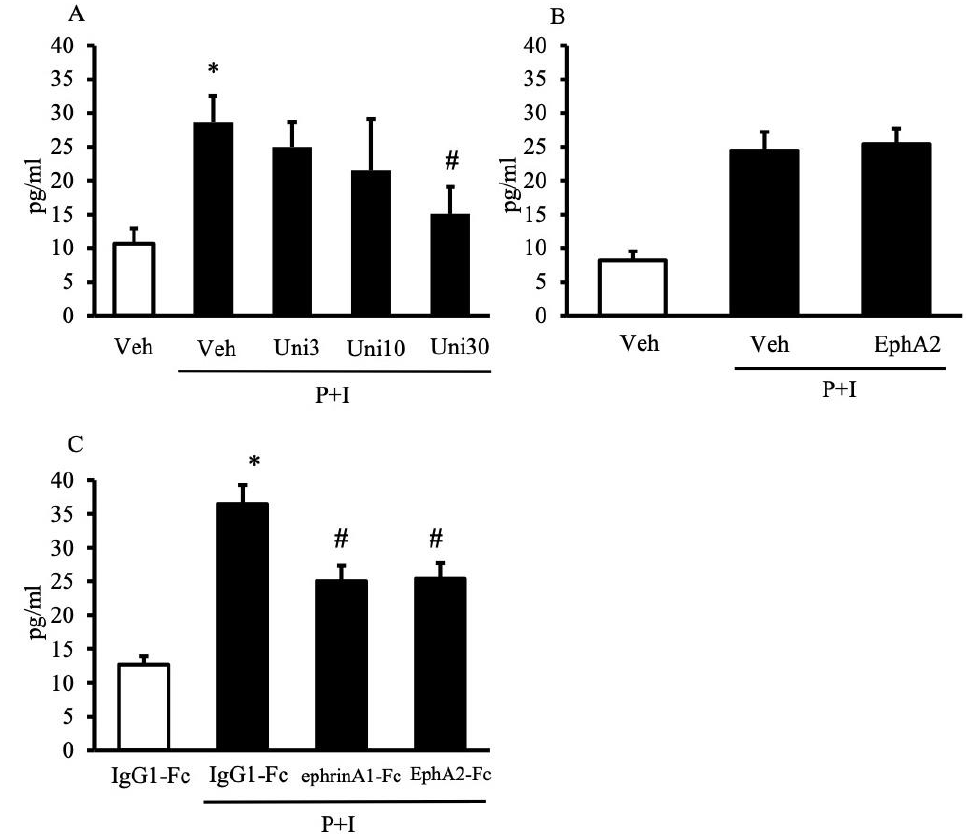
Figure 7. Effects of UniPR1331 and EphA/ephrin-A recombinant proteins on splenic mononuclear cells activation. TNF α levels, released by cultured splenic mononuclear cells, when incubated with: ( A ) DMSO 0.3% (Veh), UniPR1331 3–30 µ g/mL (Uni3, Uni10, Uni30); ( B ) saline solution (Veh), EphA2 1 µ g/mL; ( C ) IgG1-Fc 0.3 µ g/mL, ephrin-A1-Fc 0.5 µ g/mL, EphA2-Fc 1 µ g/mL. The assays were performed in the absence (white bar) or in the presence (black bars) of PMA 50 ng/mL (P) and ionomycin 500 ng/mL (I) ( n = 5–8 independent values per group). * p < 0.05 vs. unstimulated; # p < 0.05 vs. vehicle or IgG1-Fc in the presence of P + I; one-way ANOVA followed by Bonferroni’s